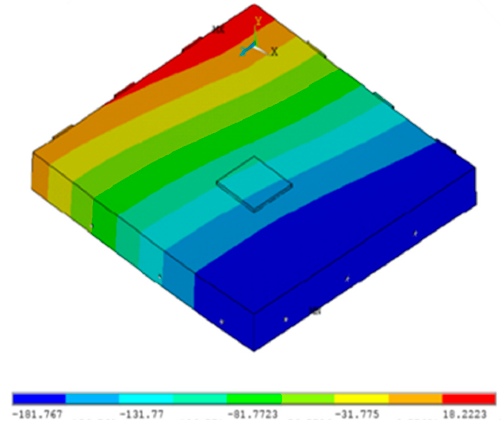
Figure 15. Deformation shape of UN slab.